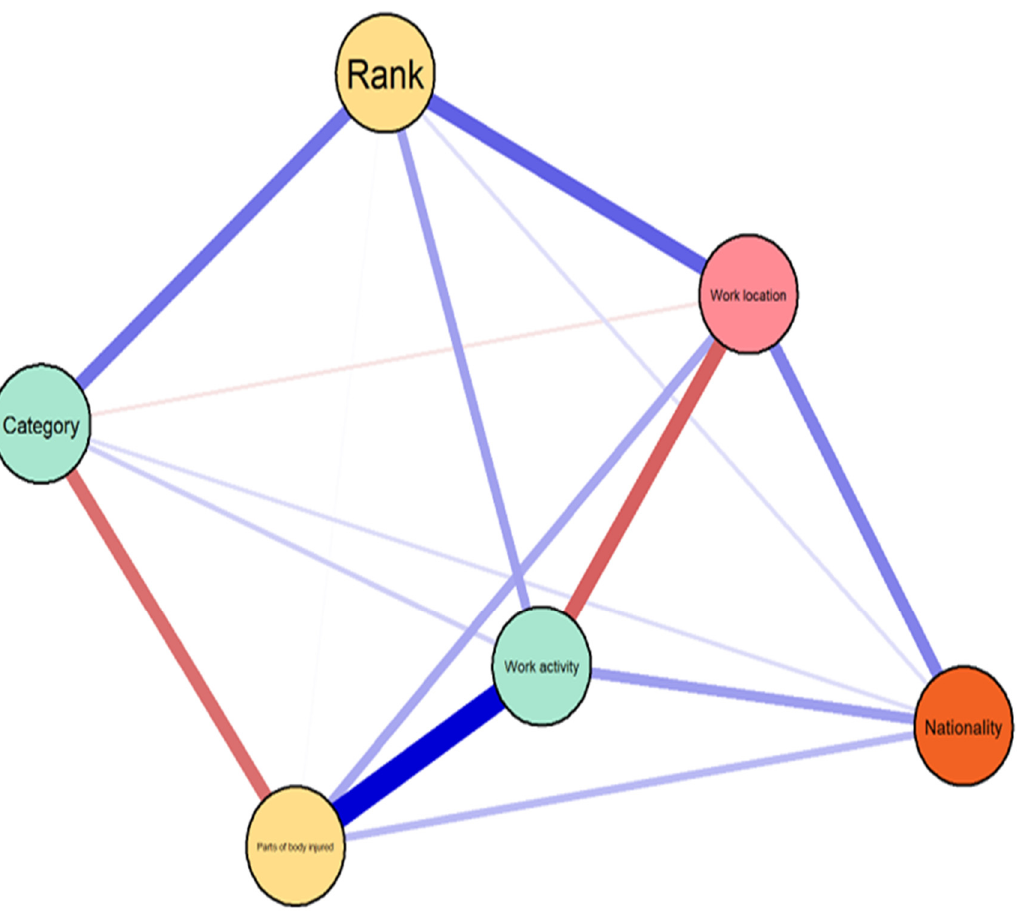
Figure 5. Mixed-Markov graphical models (MGMs) and partial correlations (pcor). Source: own process of data in RStudio.